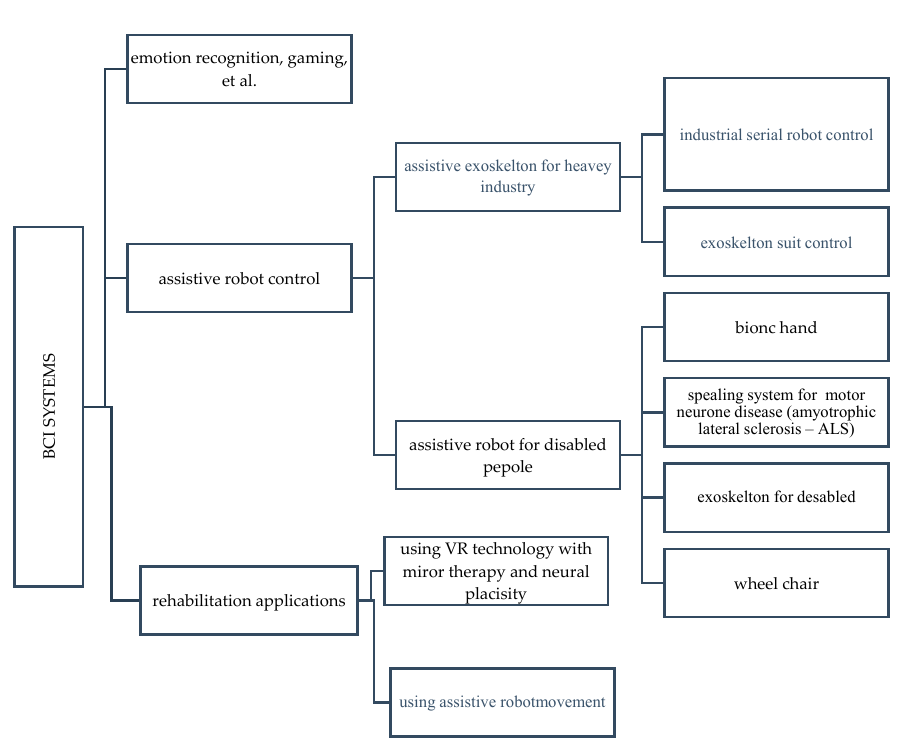
Figure 3. The different division of BCI systems based on the applications and products examples.